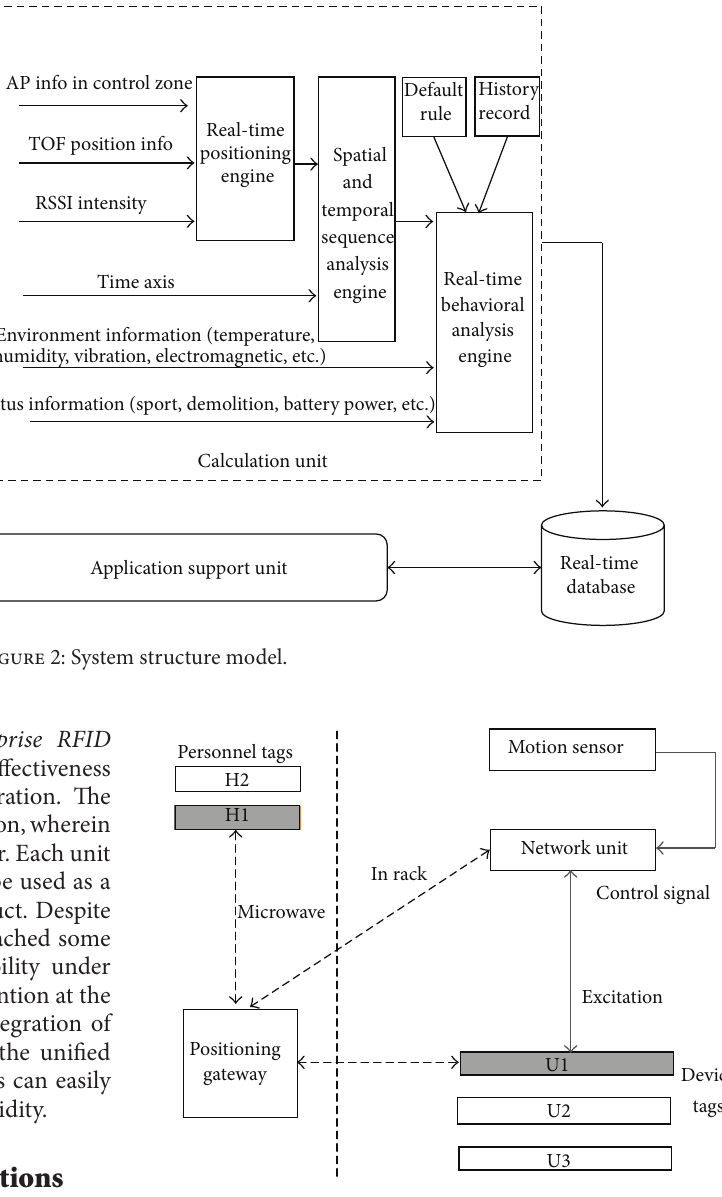
Figure 3: Design on RFID sensor application in real time